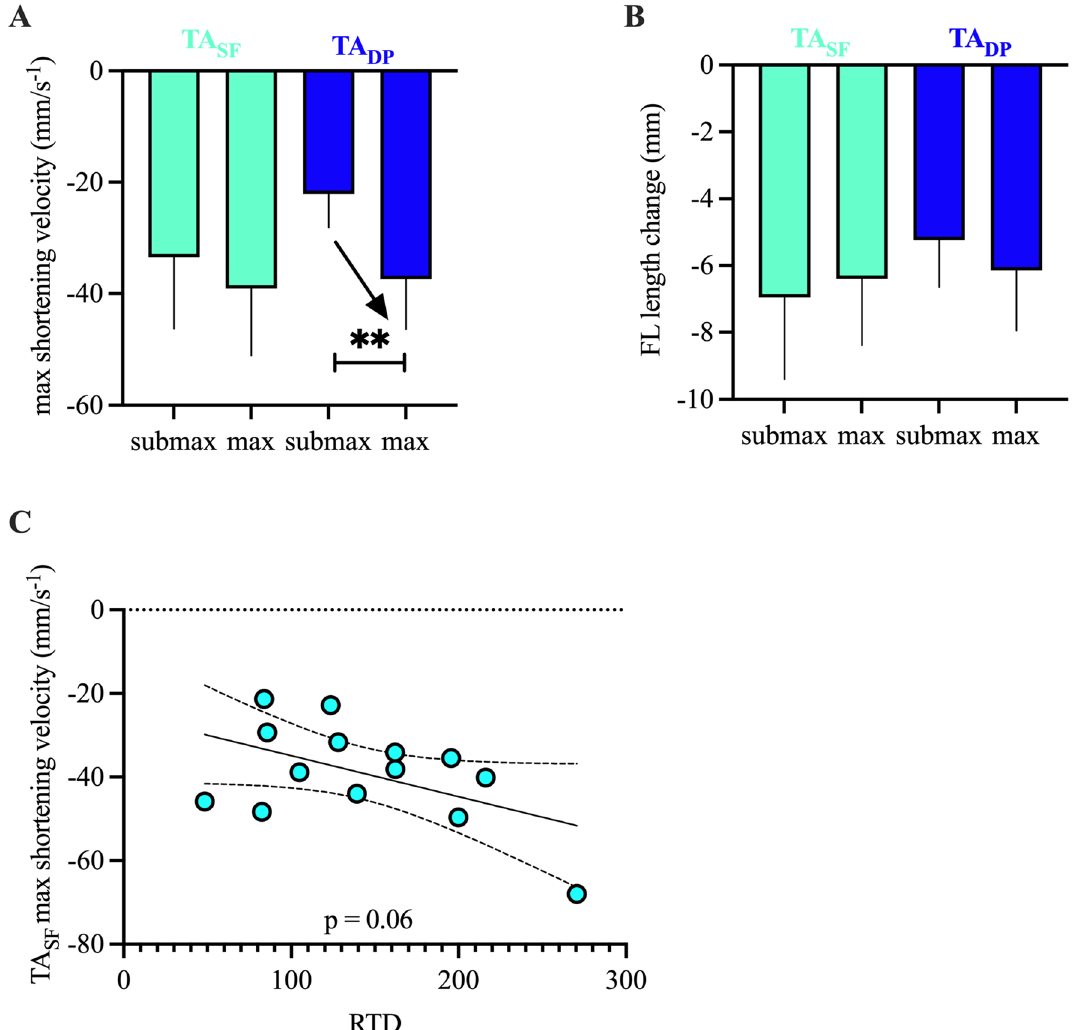
RTD (error bars show 95% confidence